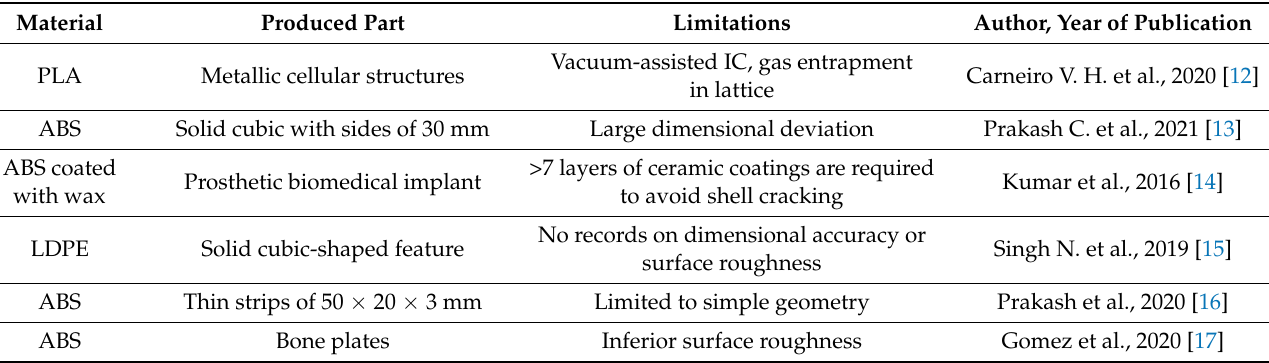
Table 1. Latest publications on the application of FDM technology in IC.